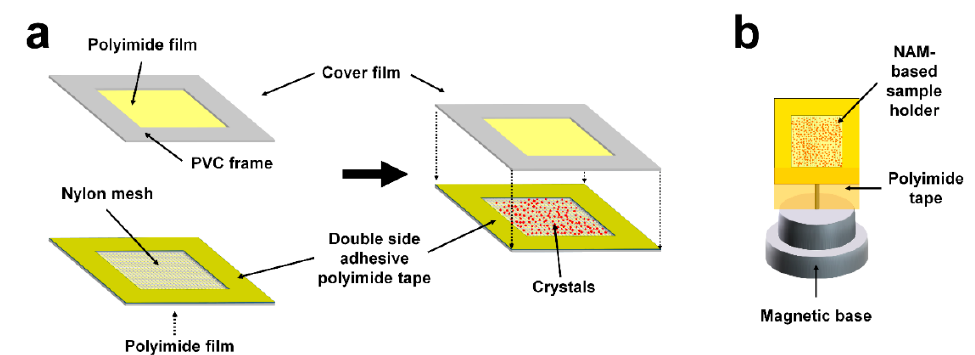
Figure 1. Preparation of the nylon mesh and enclosed film (NAM)-based sample holder for fixed-target serial synchrotron crystallography (FT-SSX). ( a ) Assembly of the sample holder; ( b ) the sample holder with magnetic base.